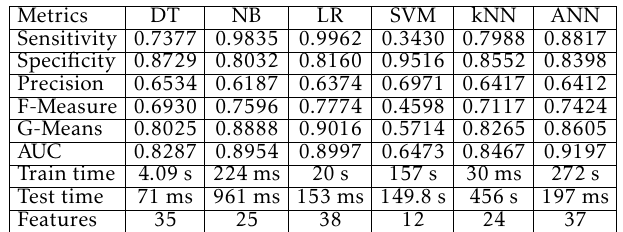
Table 27. Results of using IG-BFE algorithm on FUZZERS.